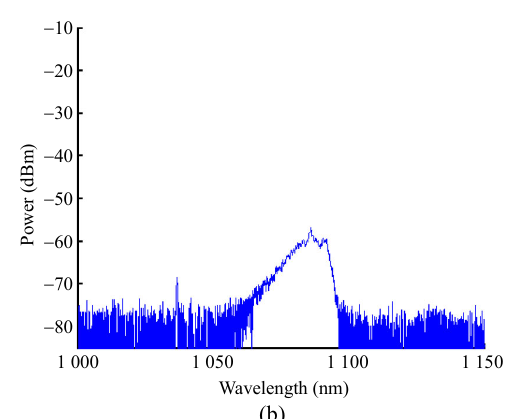
Fig. 3 Spectra of Output A with the maximal output power at different wavelengths of pump light: (a) 1030 nm, (b) 1035 nm, (c) 1040 nm, and (d) 1045 nm.